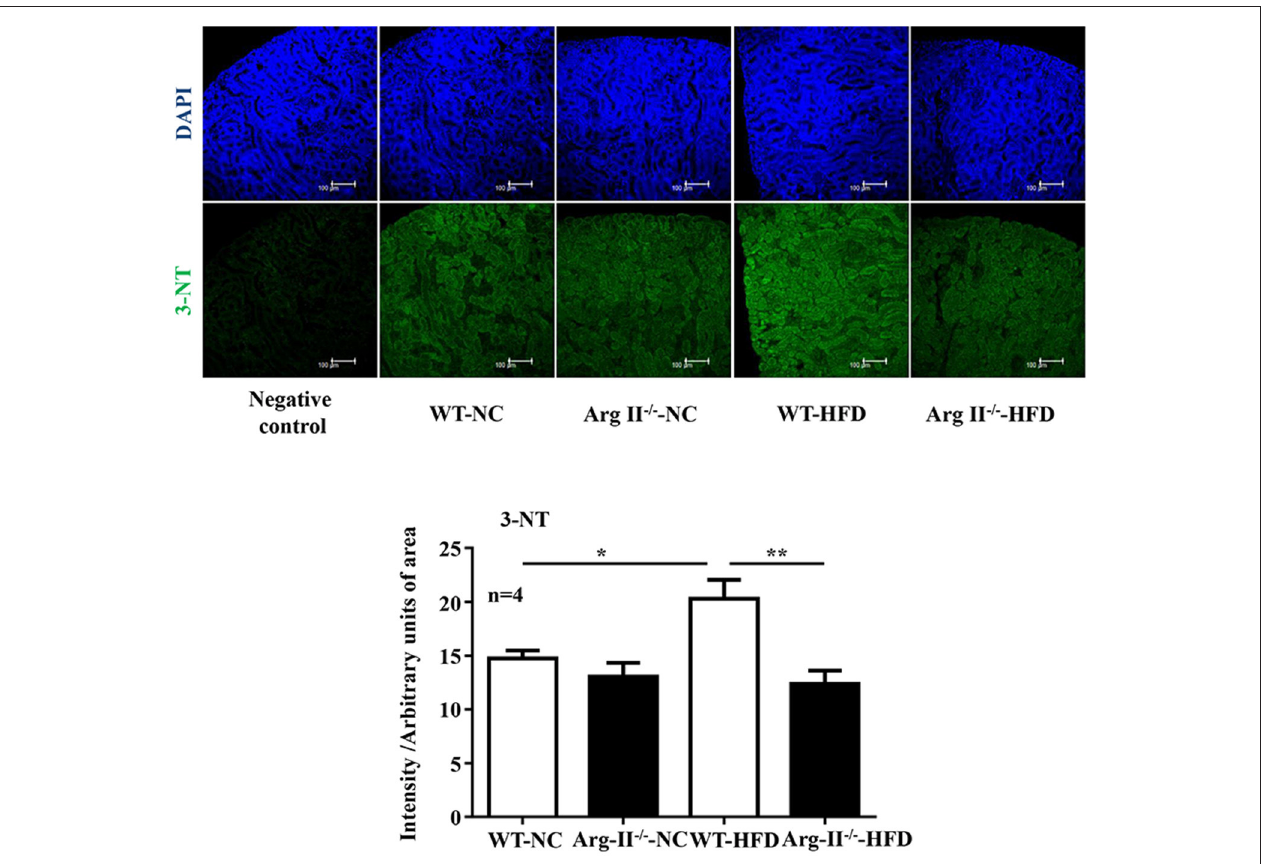
FIGURE 6 | Arg-II deficiency prevents obesity-associated increase in renal peroxynitrite formation. Confocal immunofluorescence staining of 3-NT (green) and DAPI (blue) in the kidney of WT and Arg-II − / − mice fed either normal chow (NC) or high fat diet (HFD). Representative images of individual staining and merged images are shown ( n = 4). Quantifications of 3-NT signals are shown in the bar graphs. * p < 0.05, ** p <